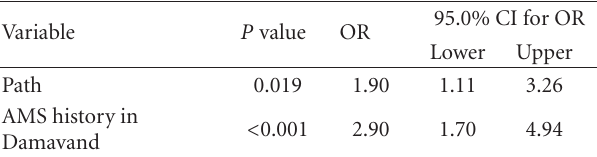
Table 5: Multiple logistic regression model to identify determinants of